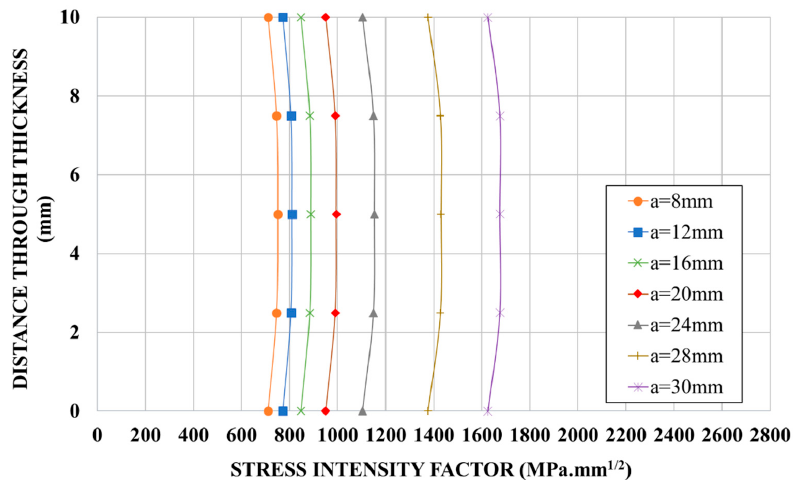
Figure 8. Distribution of SIF along crack front for un-strengthened specimens obtained from FEM (finite element model) results.